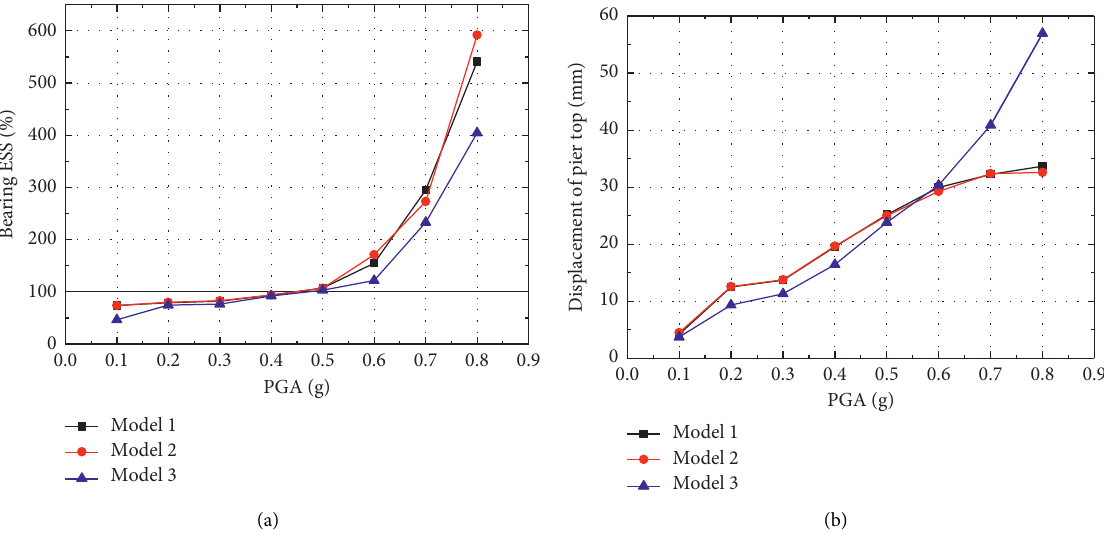
Figure 10: Comparison of (a) bearing equivalent shear strain and (b) pier displacement response using various bearing